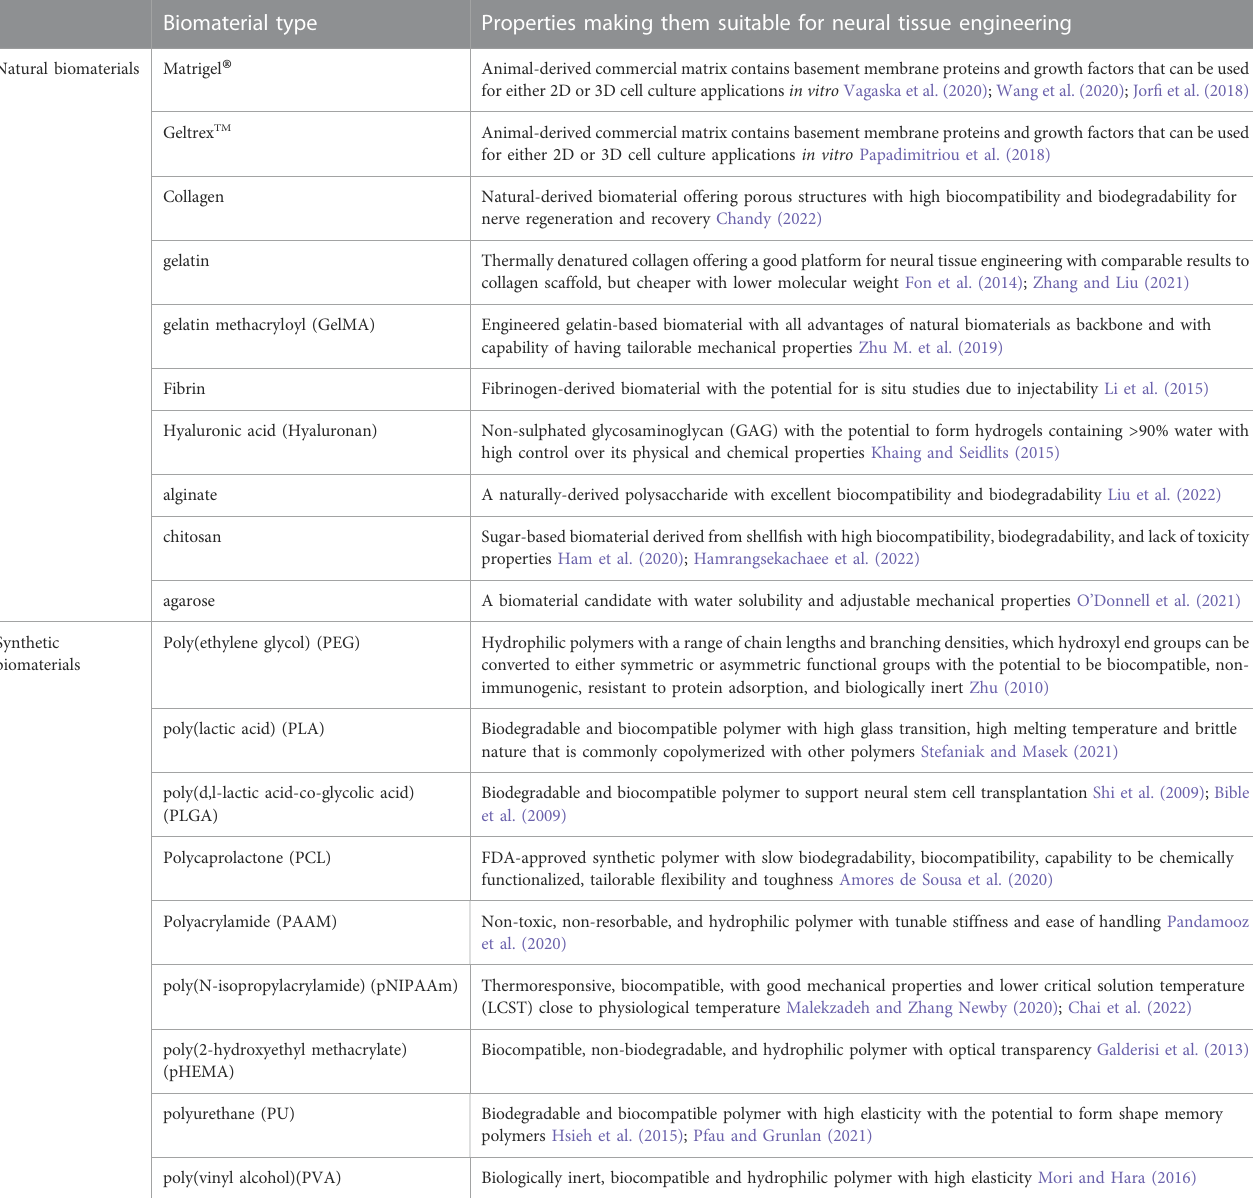
TABLE 2 The list of backbone biomaterials that are commonly used in neural stem cell ’ s niche studies. Biomaterial